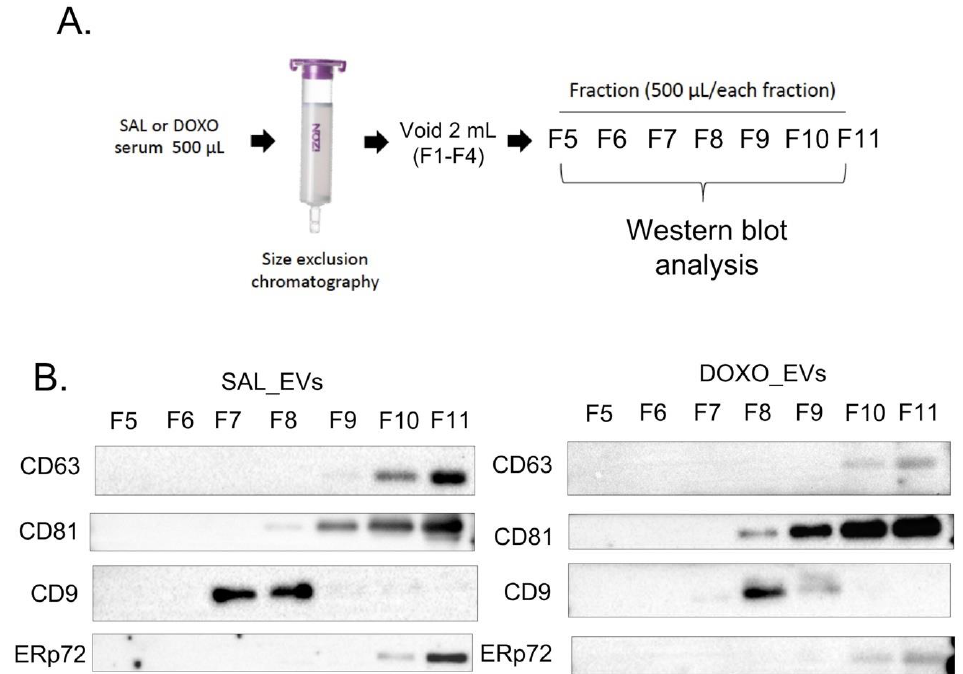
Figure 2. Diagram illustrating isolation of serum Evs using size exclusion chromatography (SEC) including void volume and collection of flow though fractions for Western blot analysis ( A ), Western blot of potential EV markers (CD63, CD9, and CD81), as well as a non-EV protein—ERp72—in fractions 5 to 11 from SEC of SAL and DOXO-rat sera ( B